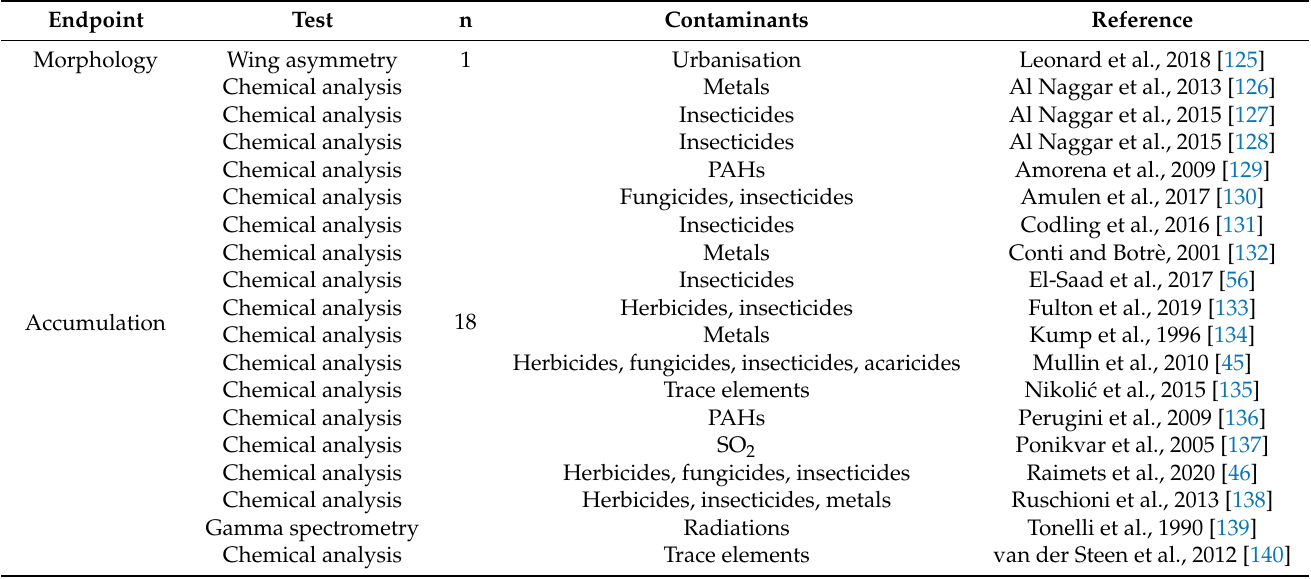
Table 5. Summary of field studies divided by endpoint and contaminants.